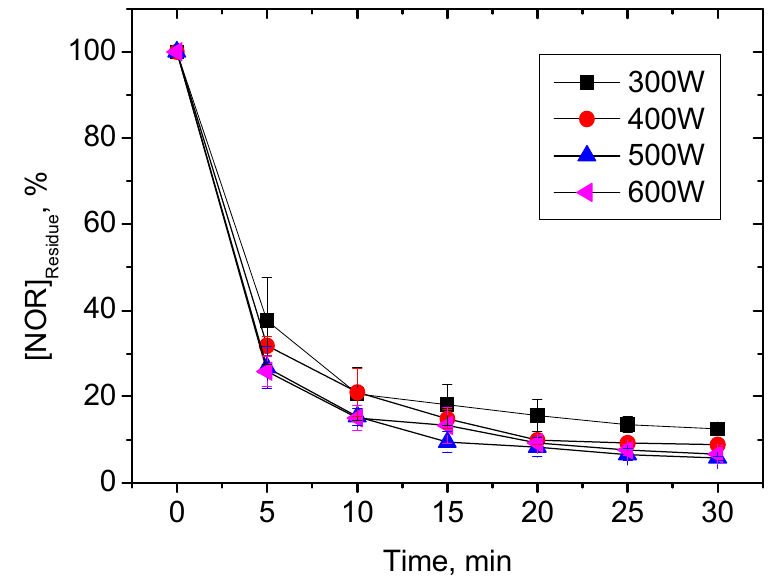
Figure 2. Effect of microwave power on the degradation of NOR by the MW/UV process. (Experimental conditions: microwave power/UV light intensity—300 W/17.1 mW/cm 2 , 400 W/23.0 mW/cm 2 , 500 W/31.8 mW/cm 2 , 600 W/42.0 mW/cm 2 ), maximum wavelength = 254 nm, [NOR] = 5 mg/L, and pH = 6.72).